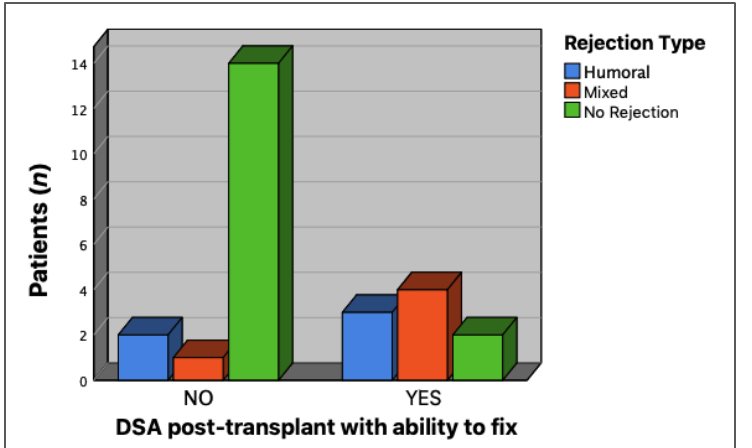
Figure 1. Association between the presence of complement-binding dnDSA and rejection events.